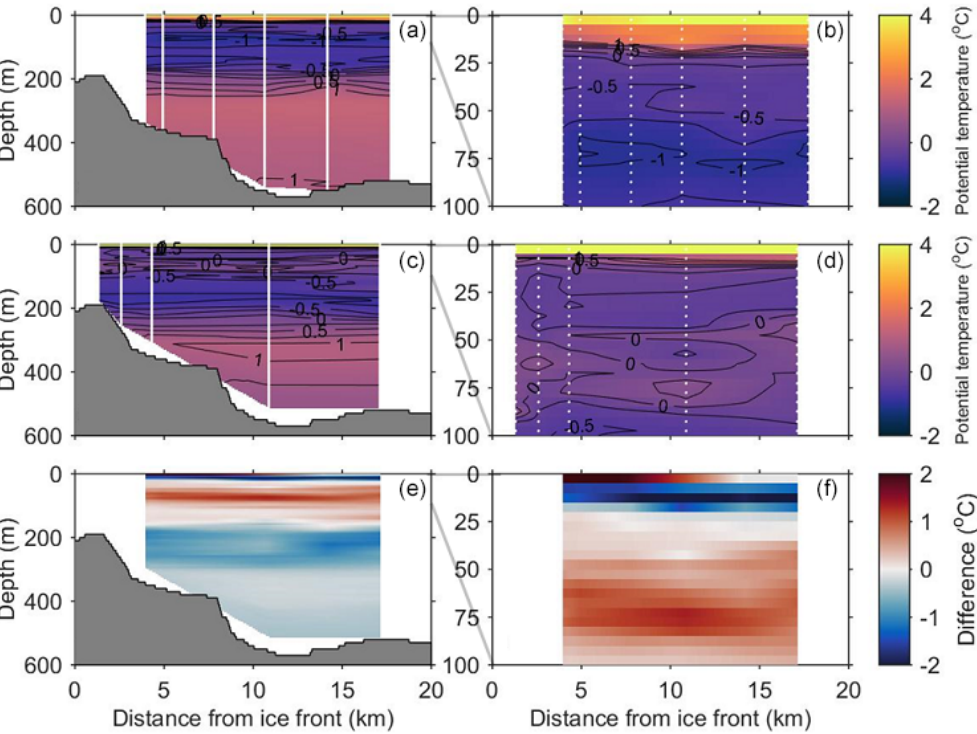
Figure 3. Contour plots of potential temperature along the centerline of Bowdoin Fjord as observed in (a) 2014 and (c) 2016. The difference between the 2 years (2016–2014) is shown in (e) . (b) , (d) , and (f) show the enlarged region from the sea surface to